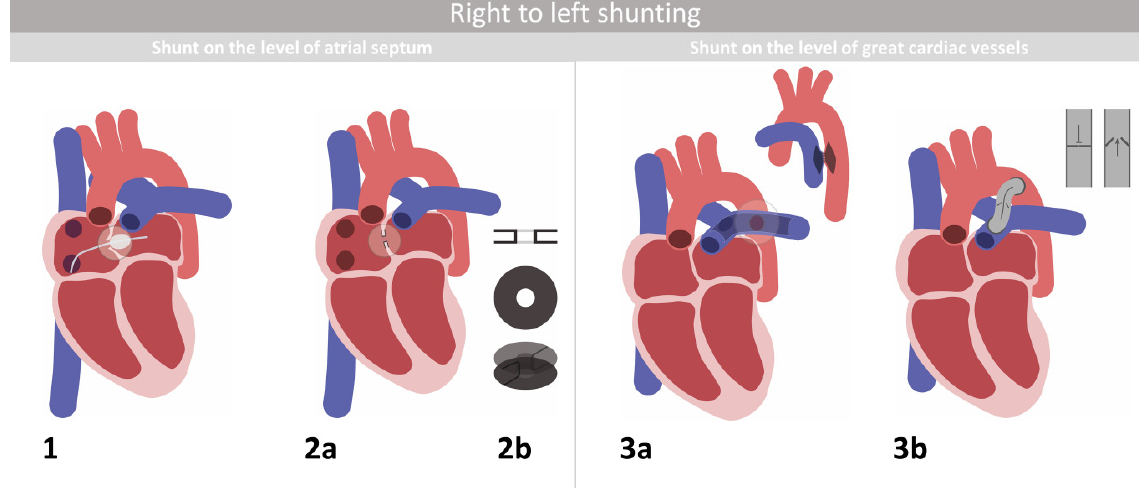
Figure 1. Treatments utilizing right-to-left shunting: ( 1 ) Atrial septostomy, ( 2a ) atrial flow regulator (AFR) at the site, ( 2b ) scheme of the AFR, ( 3a ) Potts shunting, and ( 3b ) unidirectional valve conduit as a modification of Potts shunting.